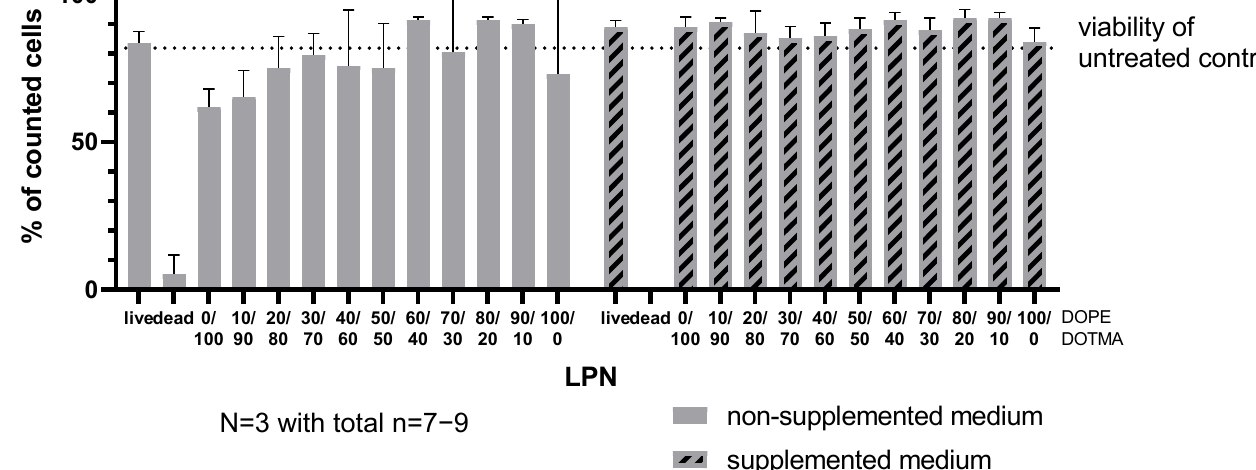
Figure 6. Viability assay. Assessment of cell membrane integrity by DAPI staining of the dendritic cell line DC2.4 after 24 h of incubation with mRNA-loaded LPNs in non-supplemented RPMI-medium vs. optimal growth medium. 5% Ethanol in HBSS ( v / v ) was used as dead control, medium without nanoparticles as live control. Analysis of cell population was performed by flow cytometry. This data set was acquired in the same experiment as the uptake and transfection. The mRNA concentration is 2 µg/mL. Only samples with high DOTMA concentration and in non-supplemented medium showed slight cell membrane damage.